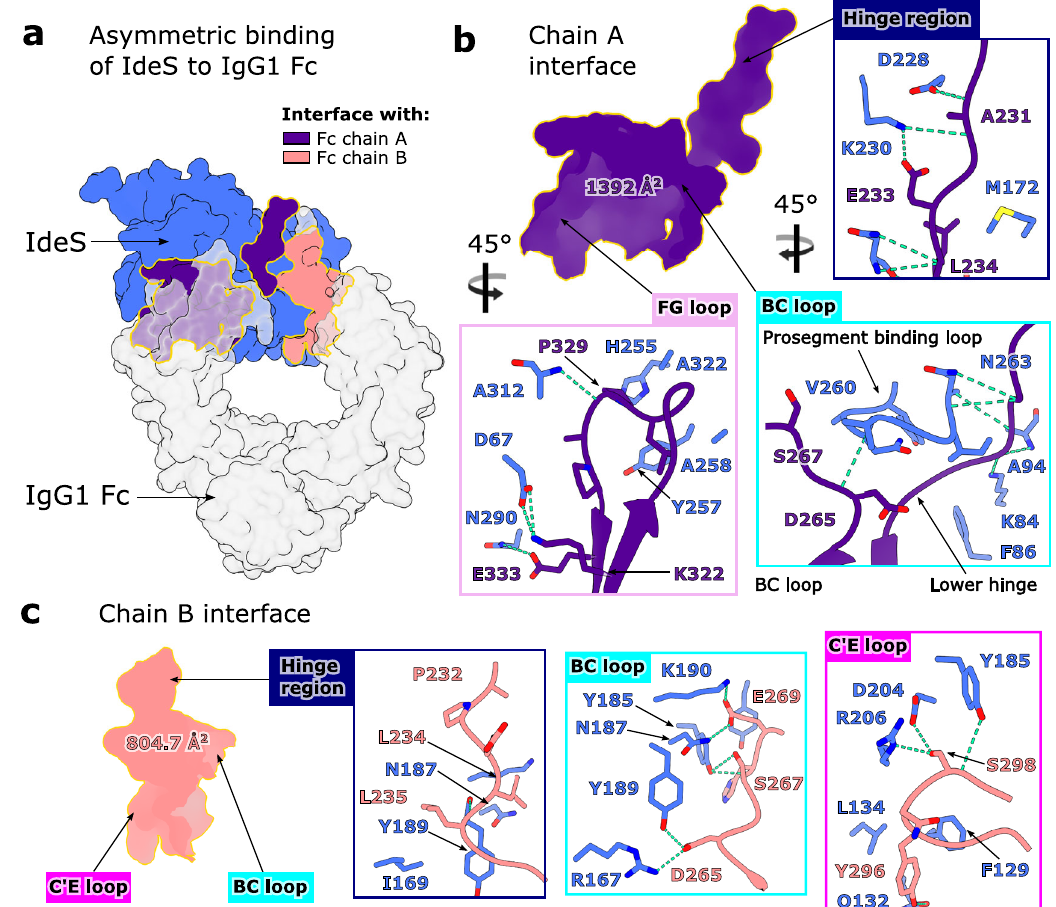
Fig. 3| AsymmetricbindinginterfaceofIdeS C94A -IgG1 Fc E382A complex.a Overall view of complex depictedas a surface, withIdeS C94A coloured blue and IgG1Fc E382A coloured silver. Interfaces of IdeS C94A with chains A and B of the Fc are coloured indigo and coral, respectively. Glycans withinthe Fchave beenomittedforclarity. b InterfacebetweenIdeS C94A andIgG1Fc E382A chainA,involvingtheFchingeregion,